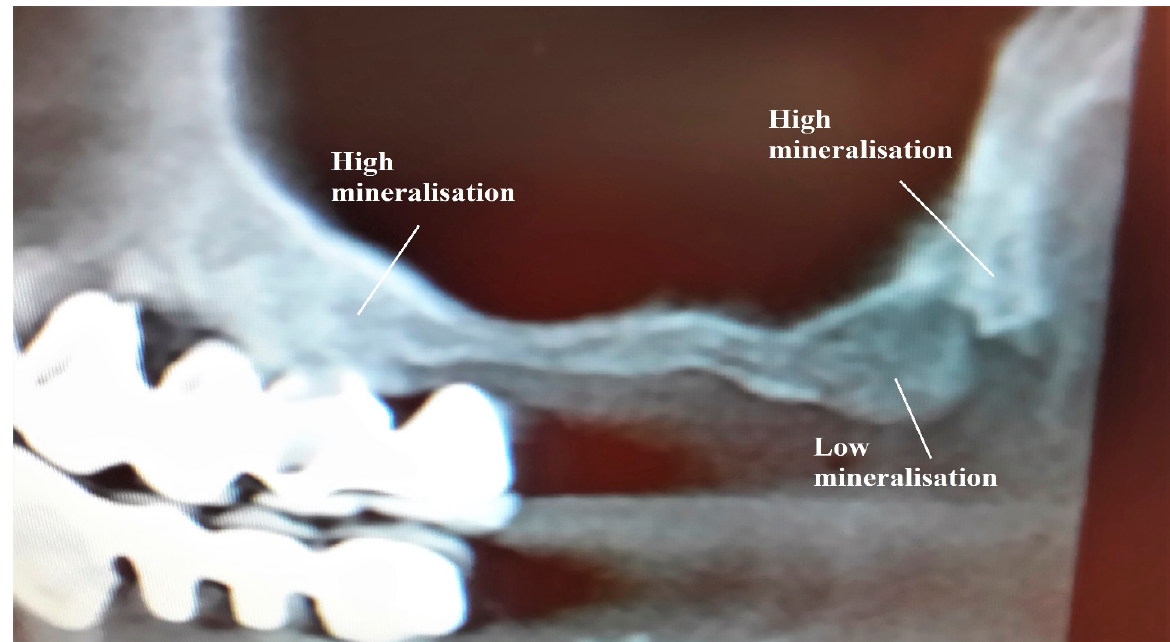
Figure 1. View from distal towards both processus pterygoidei and into the nasal cavity ( a , b ). White arrows indicate the junction zone of the pterygoid process, maxillary tuberosity and pyramidal process ( a ). Red points mark ideal penetra- tion points for the apex of the implants ( b ). This case shows a pronounced atrophy of the distal maxilla (centrifugal at- rophy) ( b ). View of lateral distal maxilla and adjacent processus pterygoidei of the sphenoid bone ( c ).